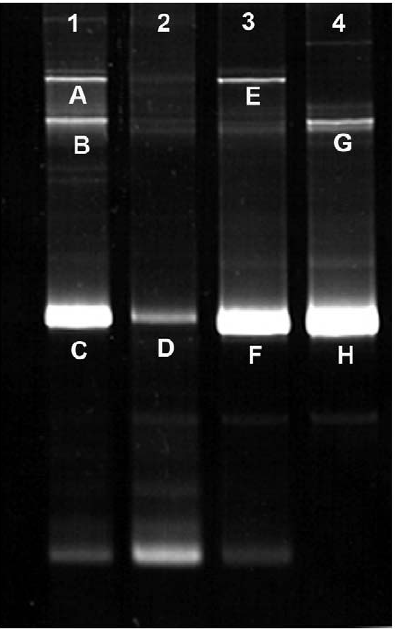
Figure 2. DGGE analysis of four HPR variants under non standardized DGGE separation. Lanes 1–2 two independent HPR2 isolates, lanes 3–4 two independent HPR7b isolates.